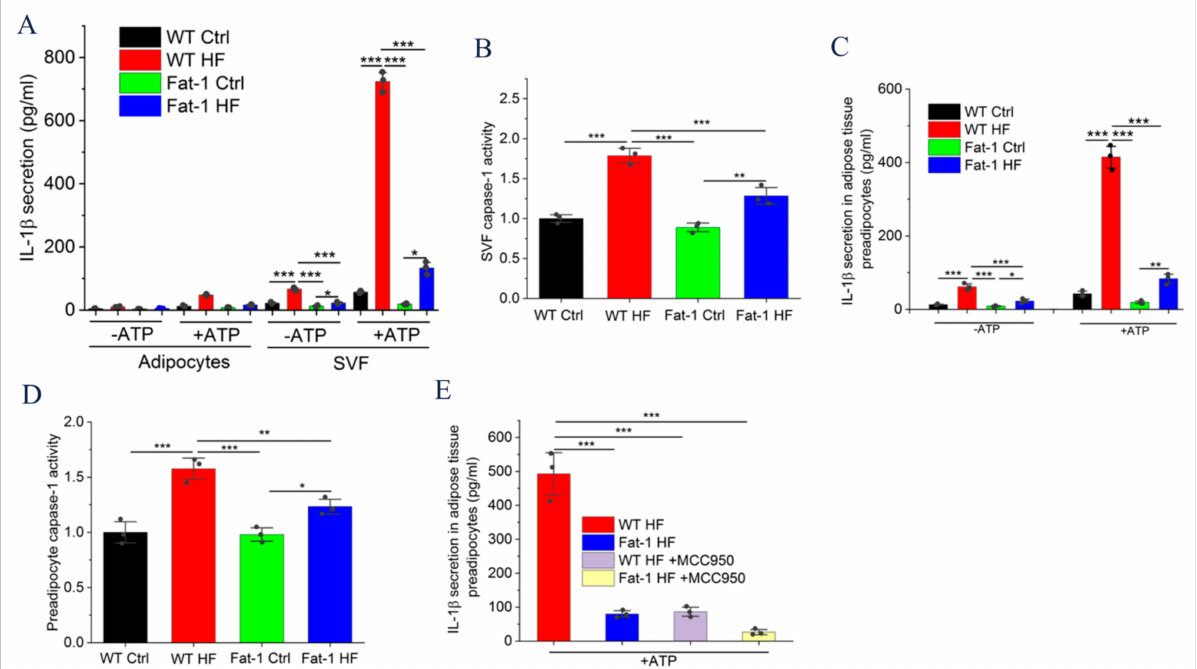
Figure 3. Endogenous n-3 PUFAs blocked caspase-1 activity and IL-1 β secretion from SVF or preadipocytes of adipose tissue isolated from Fat-1 HF mice: ( A ) Adipocytes and SVF were isolated from epididymal fat pads by collagenase digestion. IL-1 β release from the SVF (1 × 10 6 cells/mL) and adipocytes (200 µ L packed volume/mL) cultured in opti-MEM medium for 24 h with or without ATP (5 mmol/L) was measured by ELISA; ( B ) Caspase-1 activity was detected in the SVF treated with ATP (5 mmol/L) for 24 h; ( C ) Preadipocytes isolated from adipose tissue were cultured in opti-MEM medium for 24 h with or without ATP (5 mmol/L) and IL-1 β release was detected in culture media by ELISA; ( D ) Caspase-1 activity was detected in the preadipocytes treated with ATP (5 mmol/L) for 24 h; ( E ) Preadipocytes isolated from adipose tissue of WT HF and Fat-1 HF were cultured in opti-MEM medium for 24 h with or without MCC950 (NLRP3 inflammasome inhibitor) and IL-1 β released into culture media was measured by ELISA. Results are presented as mean ± SEM, * p < 0.05, ** p < 0.01 and *** p <